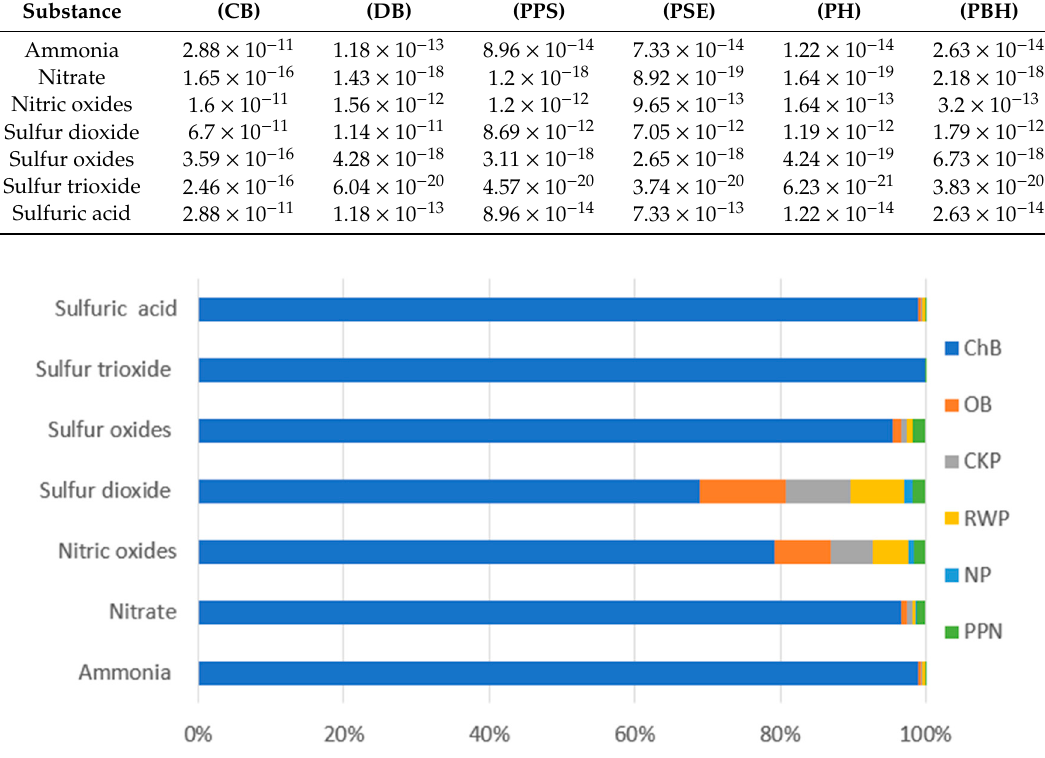
Table 9. Results of characterization of environmental impacts for the land acidification category (species.yr).